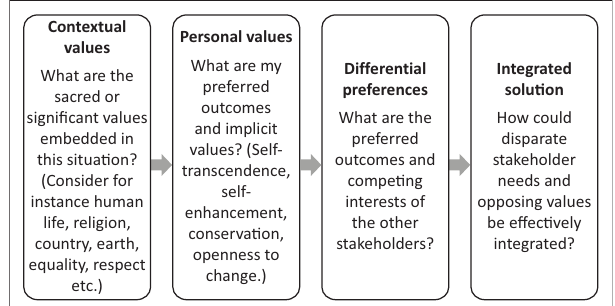
FIG URE 4: Decision-making framework for value-laden